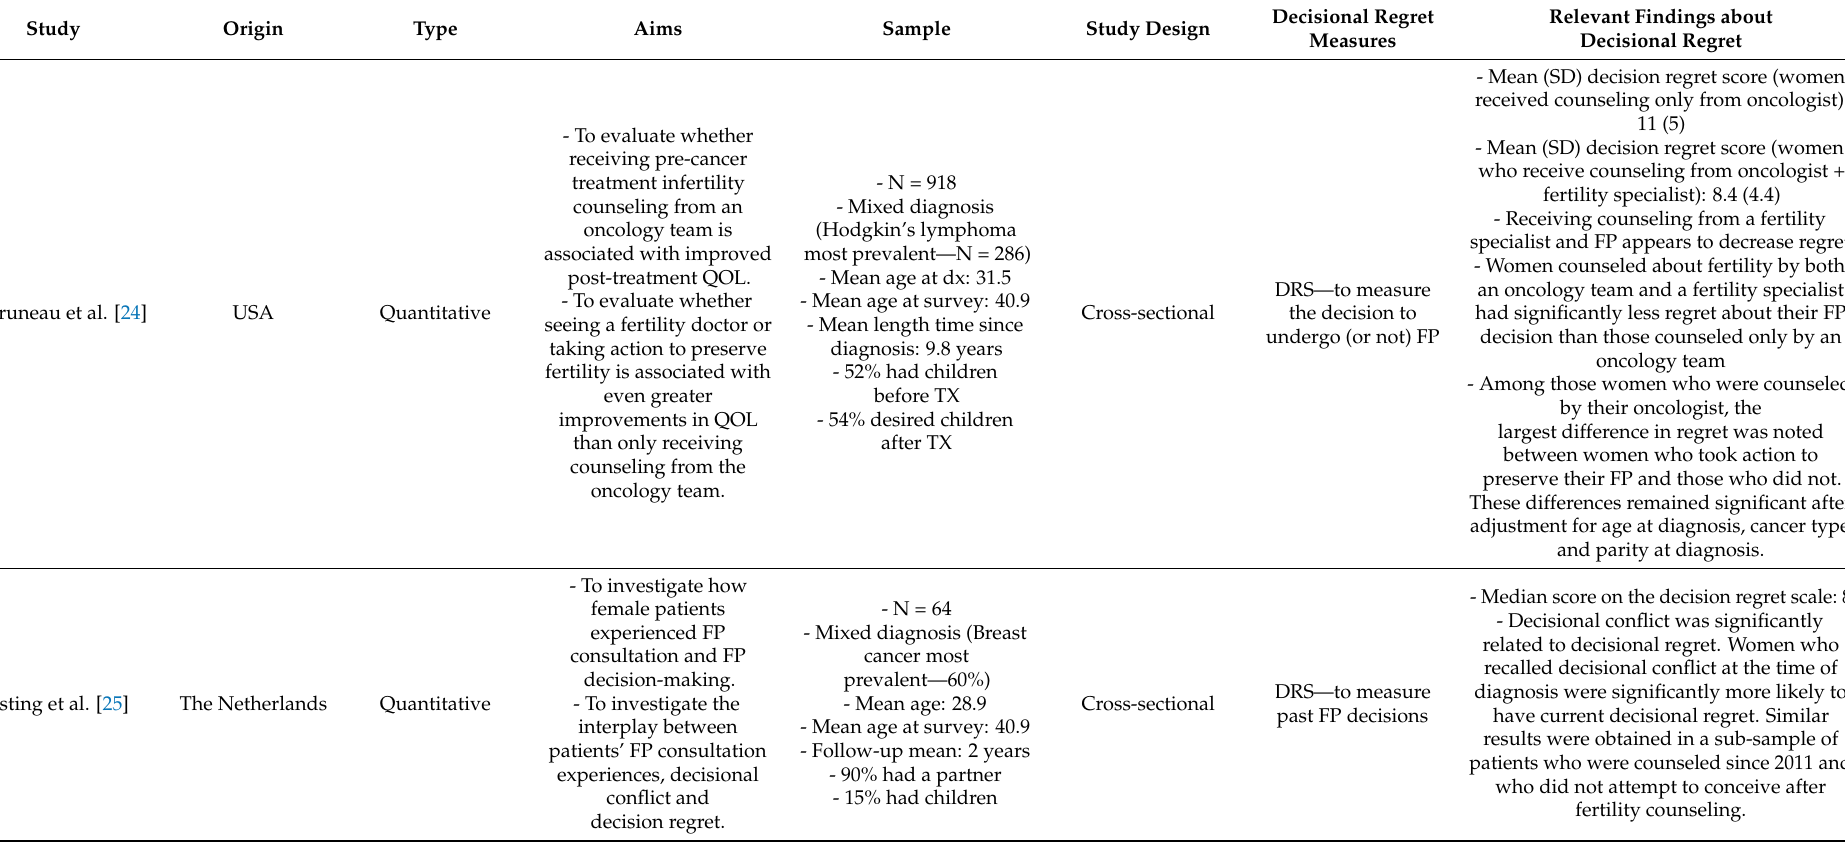
Table 1. Studies addressing decisional regret regarding fertility decisions of women at reproductive age diagnosed with